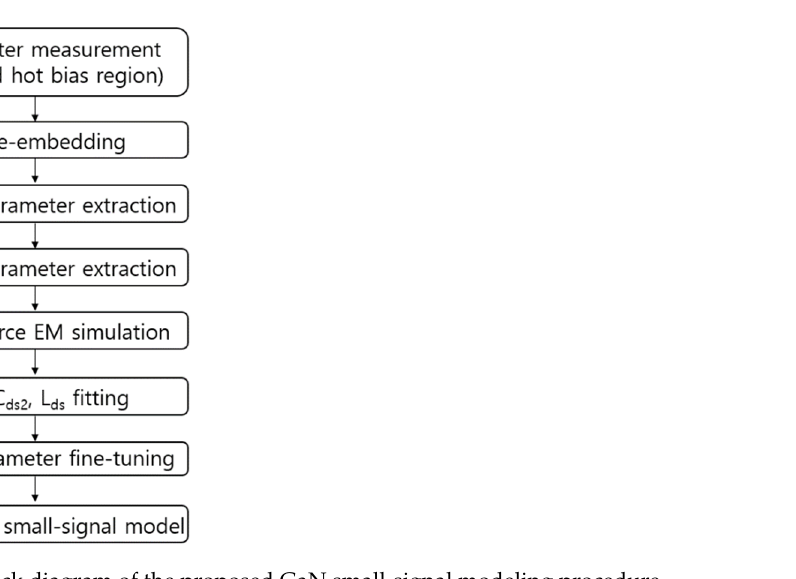
Figure 8. Block diagram of the proposed GaN small-signal modeling procedure.